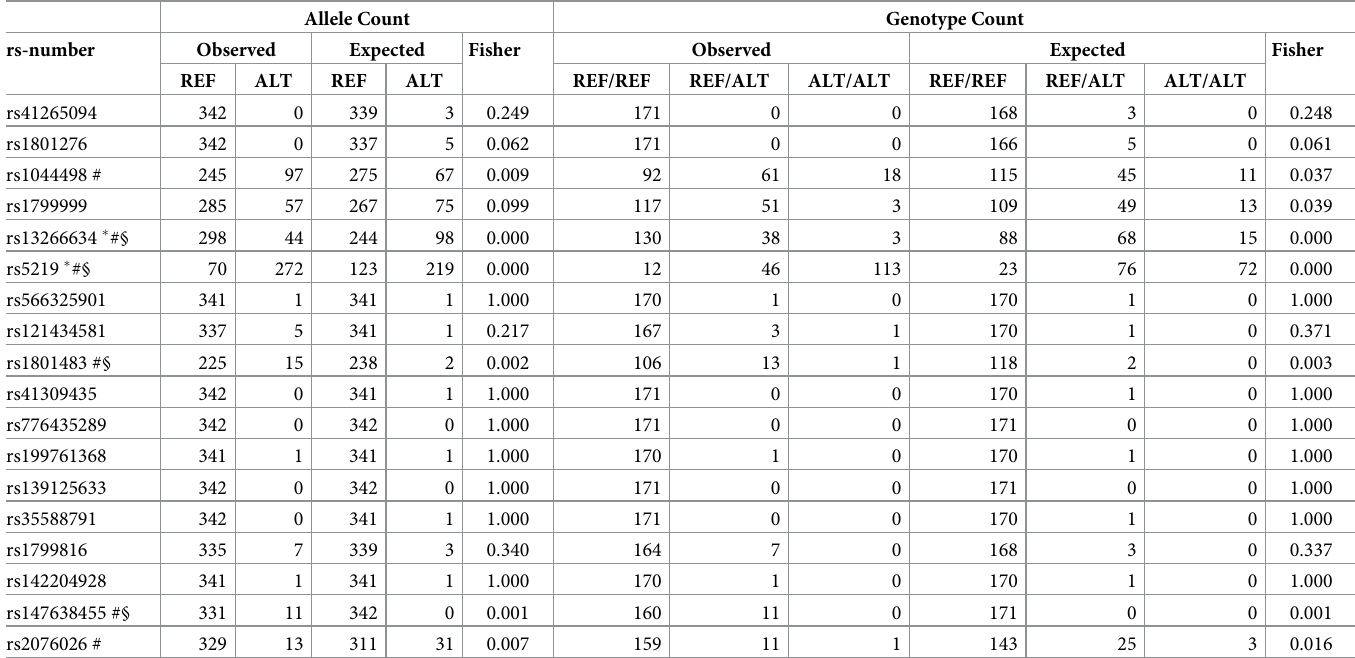
Table 2. Results of Fisher’s exact test for T2D-related SNPs.